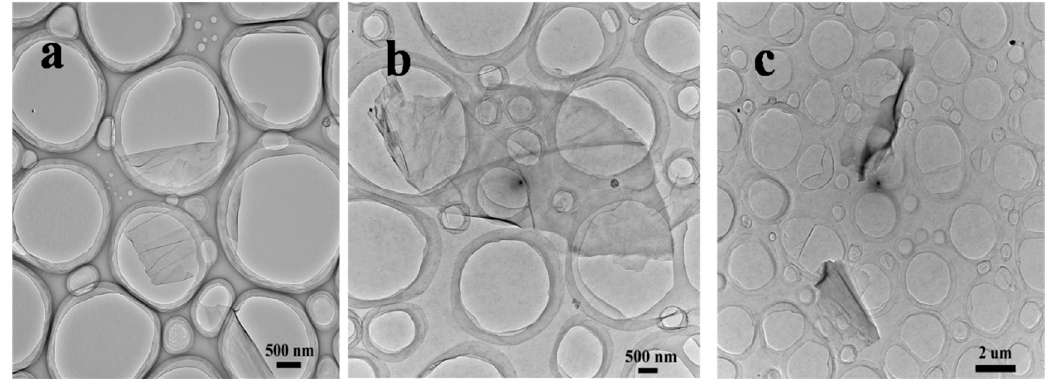
Figure 3. Transmission electron microscopy (TEM) micrographs of ( a ) GO, and ( b , c ) SPCM6.